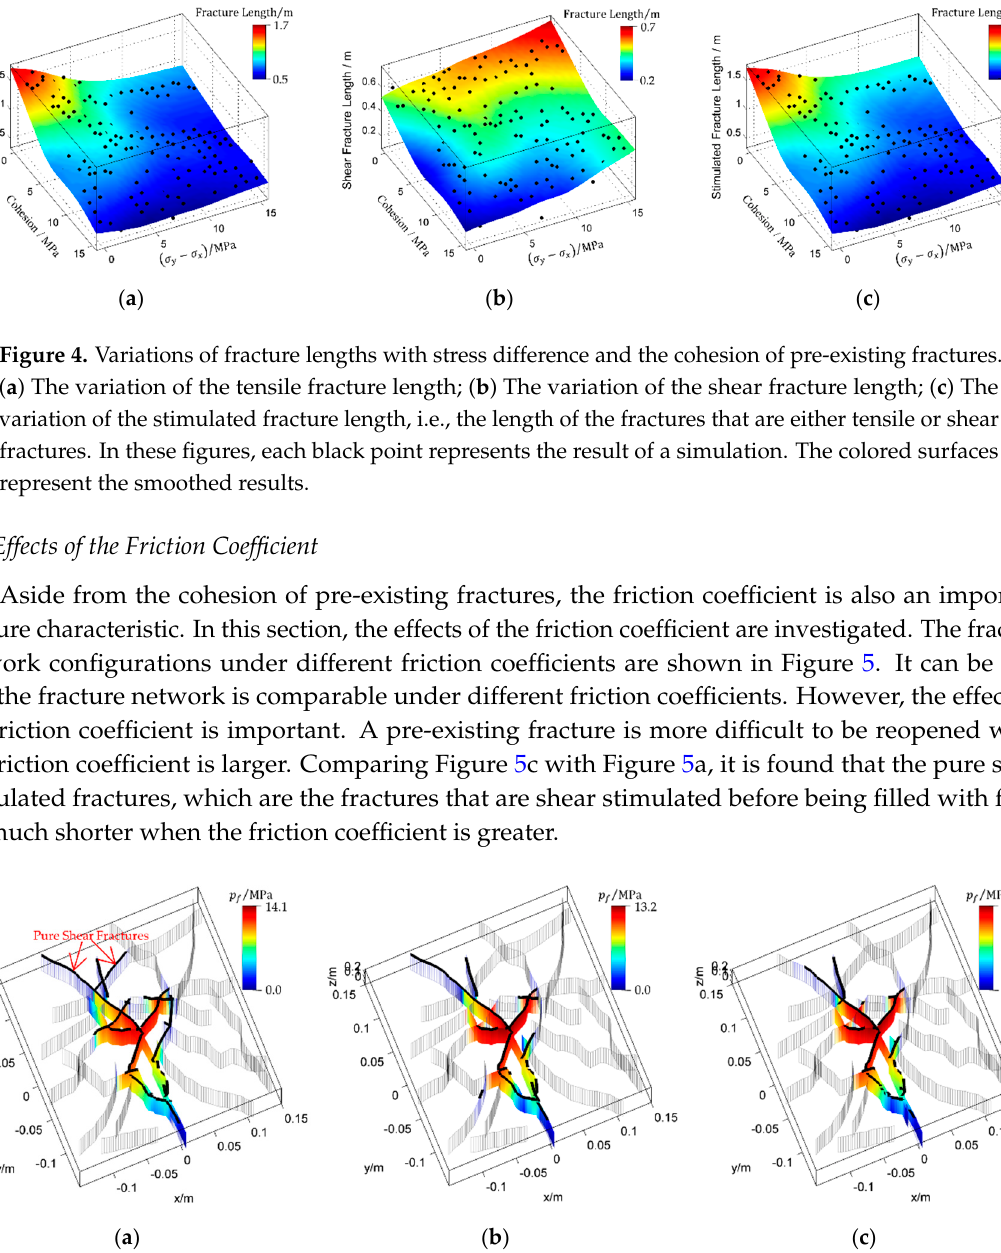
Figure 5. Fracture network configurations under different values of the friction coefficient. ( a ) λ = 0.4; ( b ) λ = 0.7; ( c ) λ = 1.0. Here, λ refers to the friction coefficient between fracture surfaces. For the fluid-affected fractures, the fluid pressure ( p f ) is represented by color. The fractures that are not affected by fluid are represented by the gray meshes. The shear fractures are marked by the bold curves at the top. The stress difference σ y − σ x is equal to 10 MPa in these